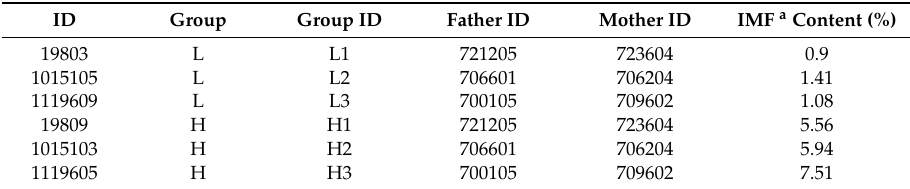
Table 1. Pedigree and phenotype information of selected